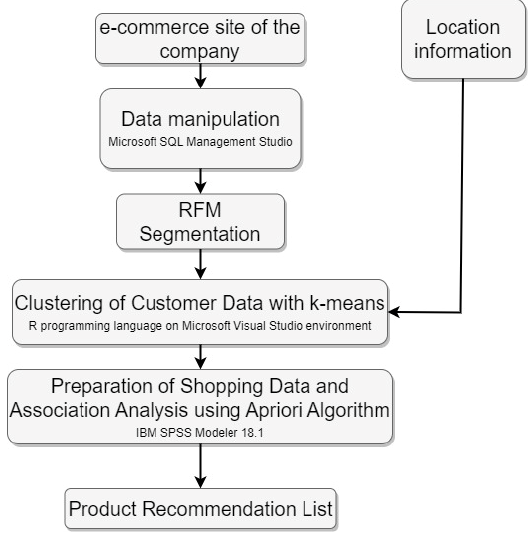
Figure 6. Schematic presentation of experimental